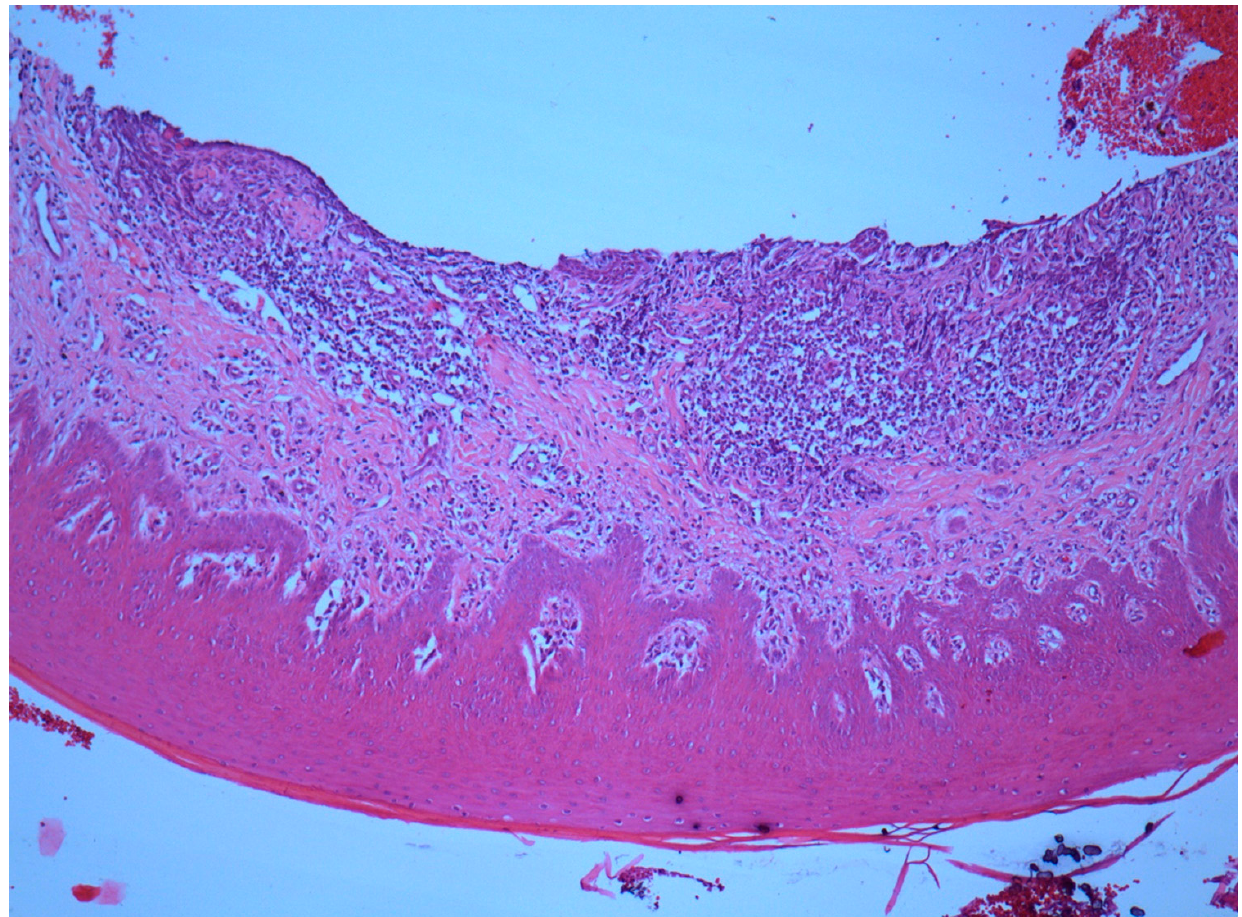
Figure 7. Control group (wound healing by second intention) biopsied after 90 days with very marked infiltration (10 × ).